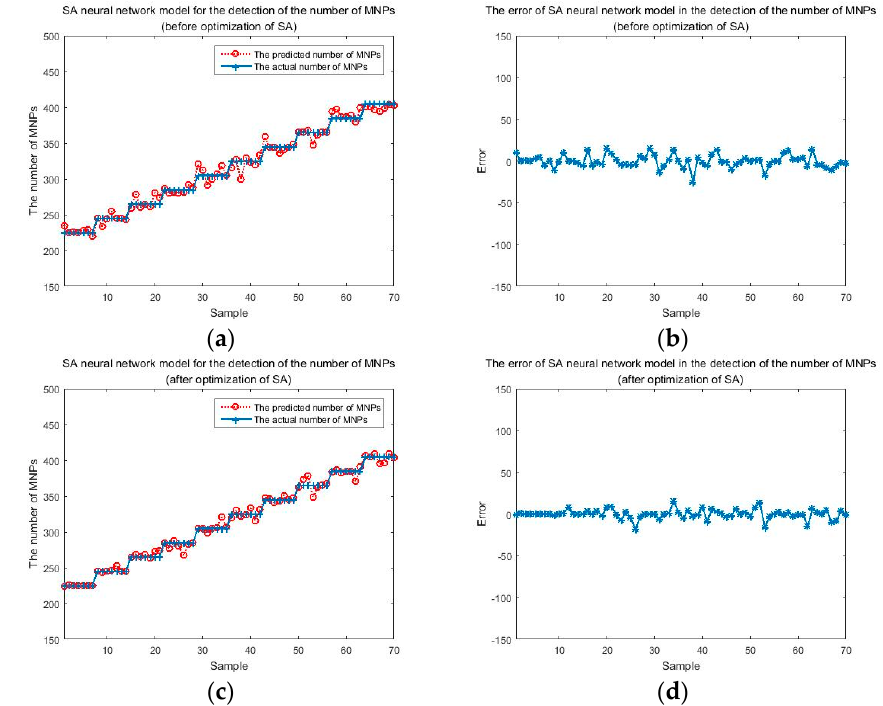
Figure 10. The Comparison diagram of prediction effect of neural network model before and after the optimization of Simulated Annealing (SA): ( a ) MNPs measurement model through the optimization of SA (before optimization), ( b ) the detection error in MNPs measurement model (before optimization), ( c ) MNPs measurement model through the optimization of SA (after optimization), and ( d ) the detection error in MNPs measurement model (after optimization).